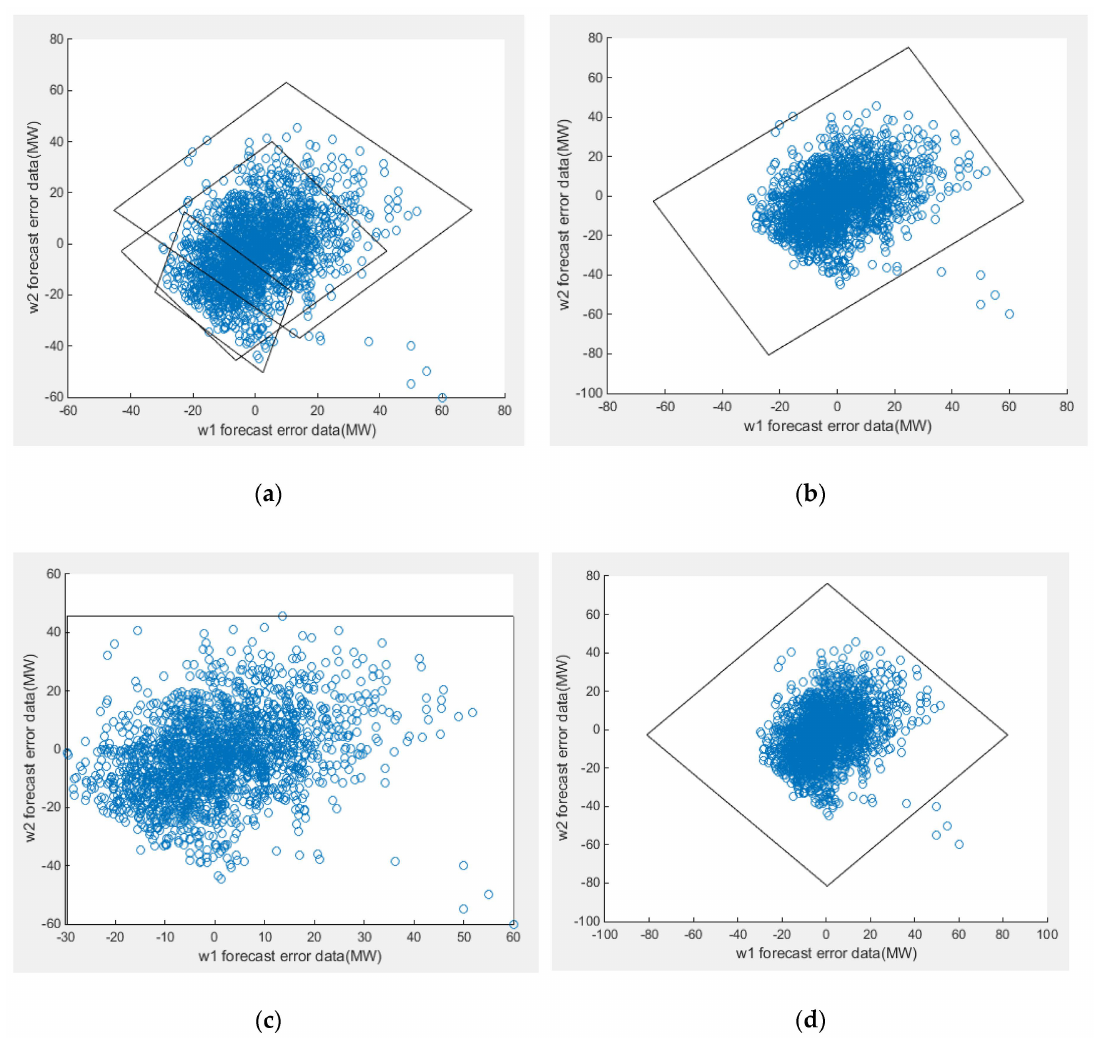
Figure 6. ( a ) Data driven robust uncertainty set W D uncertainty set; ( d ) gamma uncertainty